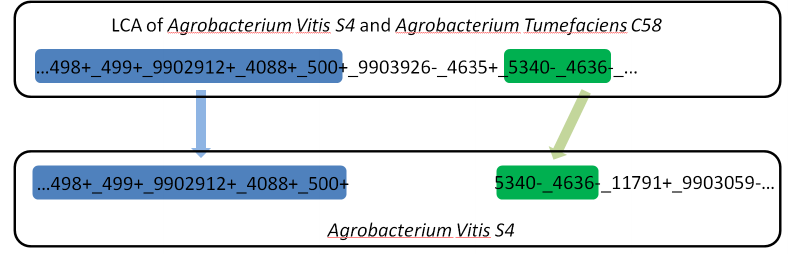
Figure 4. A long gene run on the main chromosome split into two smaller fragments during the evolutionary path from the LCA of Agrobacterium vitis S4 and Agrobacterium tumefaciens C58 to Agrobacterium vitis S4. Each number represents a gene and the underscore represents adjacency. + / − symbols represent the gene orientation determined during the reconstruction. Some genes on both ends are omitted for